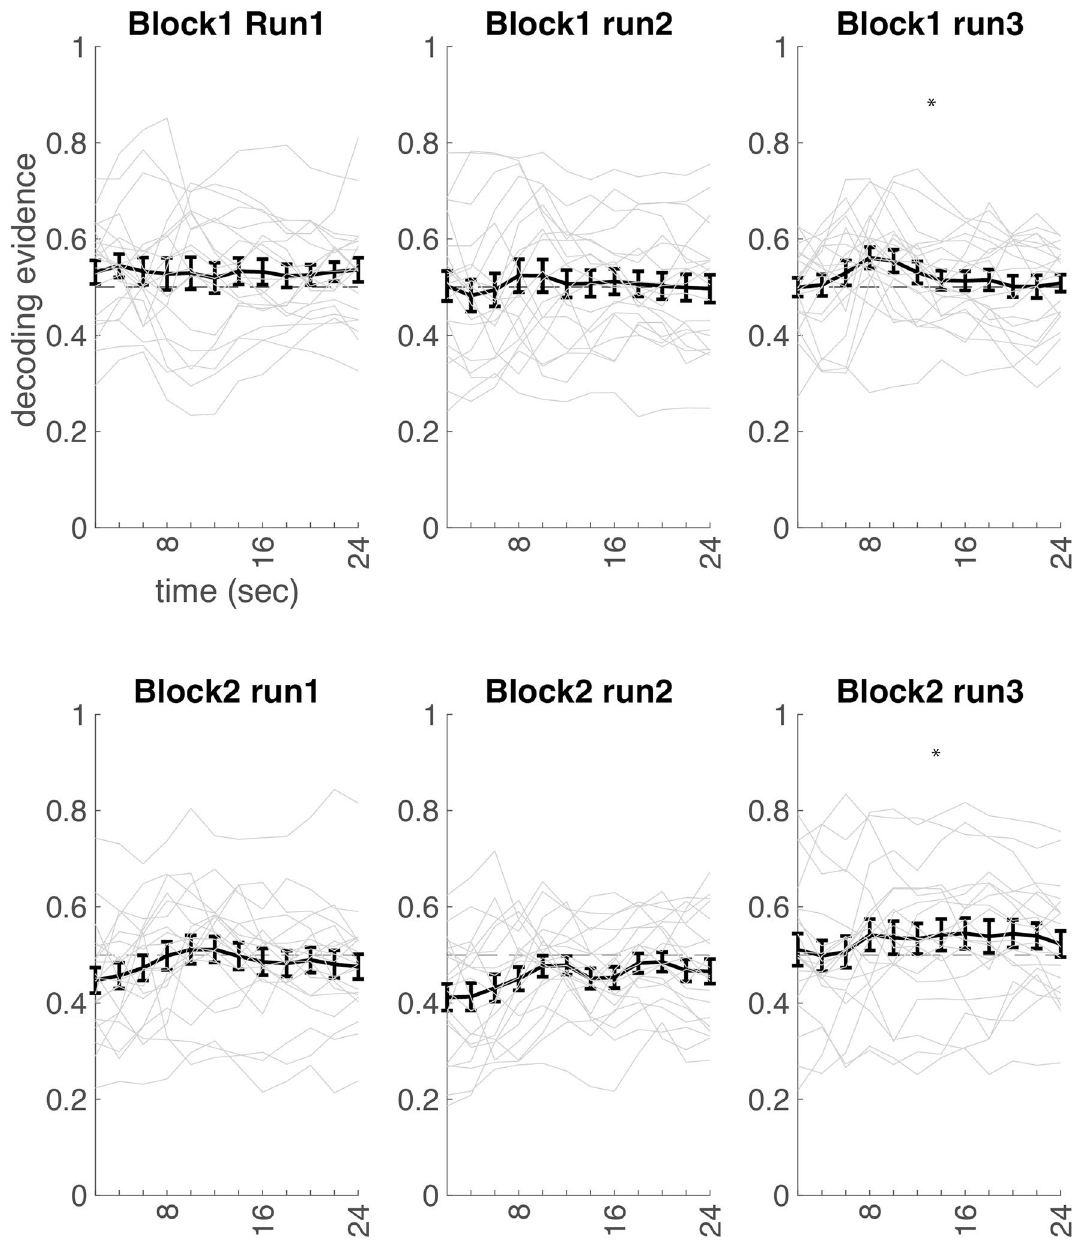
Figure 4. Decoding evidence. Decoding evidence of the correct category (face or scene) during neurofeedback over time, thus, separately for block 1 and 2, and separately for run 1, 2 and 3 (averaged across all trials of that run). Blocks are labeled block 1 and 2 since it is counterbalanced across participants which of the two blocks is face neurofeedback and which is scene neurofeedback. 0.5 is chance level, indicated by the dashed line. Error bars represent SEM. Grey lines represent single-subject data. The object is presented on the screen the first 2 s, the neurofeedback presentation (see Fig. 1B) is presented in the remaining 22